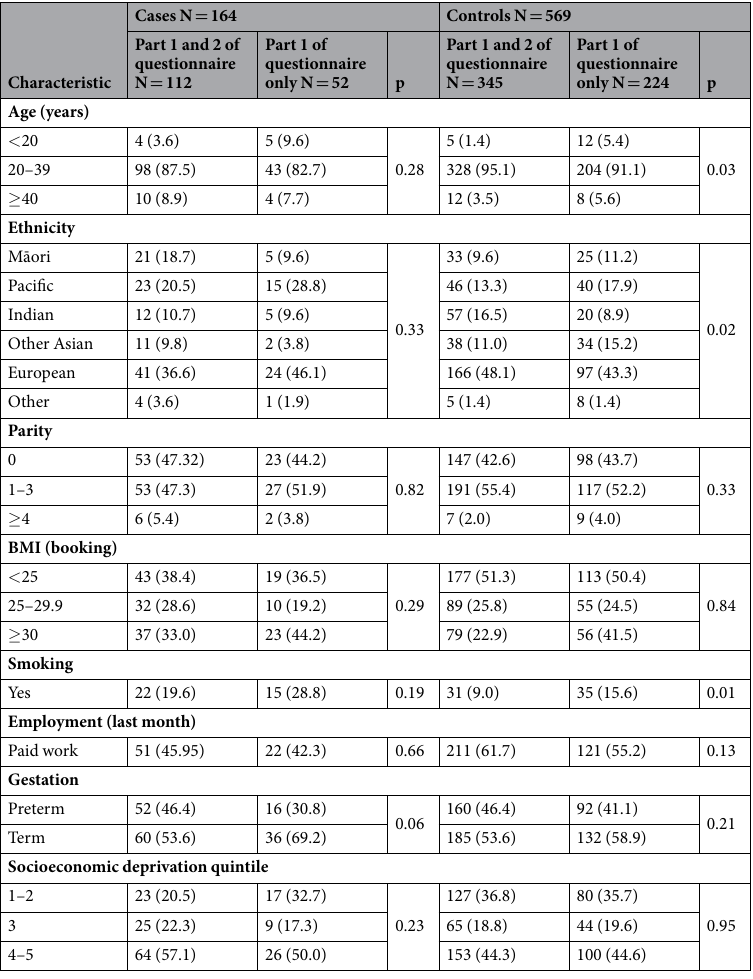
Table 1. Participant characteristics. Data are n (%). FM, fetal movement; BMI, body mass index (kg/m 2 ). Quintiles 4 and 5 are the most socioeconomically deprived. Part 1 of the questionnaire was completed by all participants interviewed between February 2012 and December 2015. Part 1 and Part 2 was completed by those interviewed between July 2013 and December